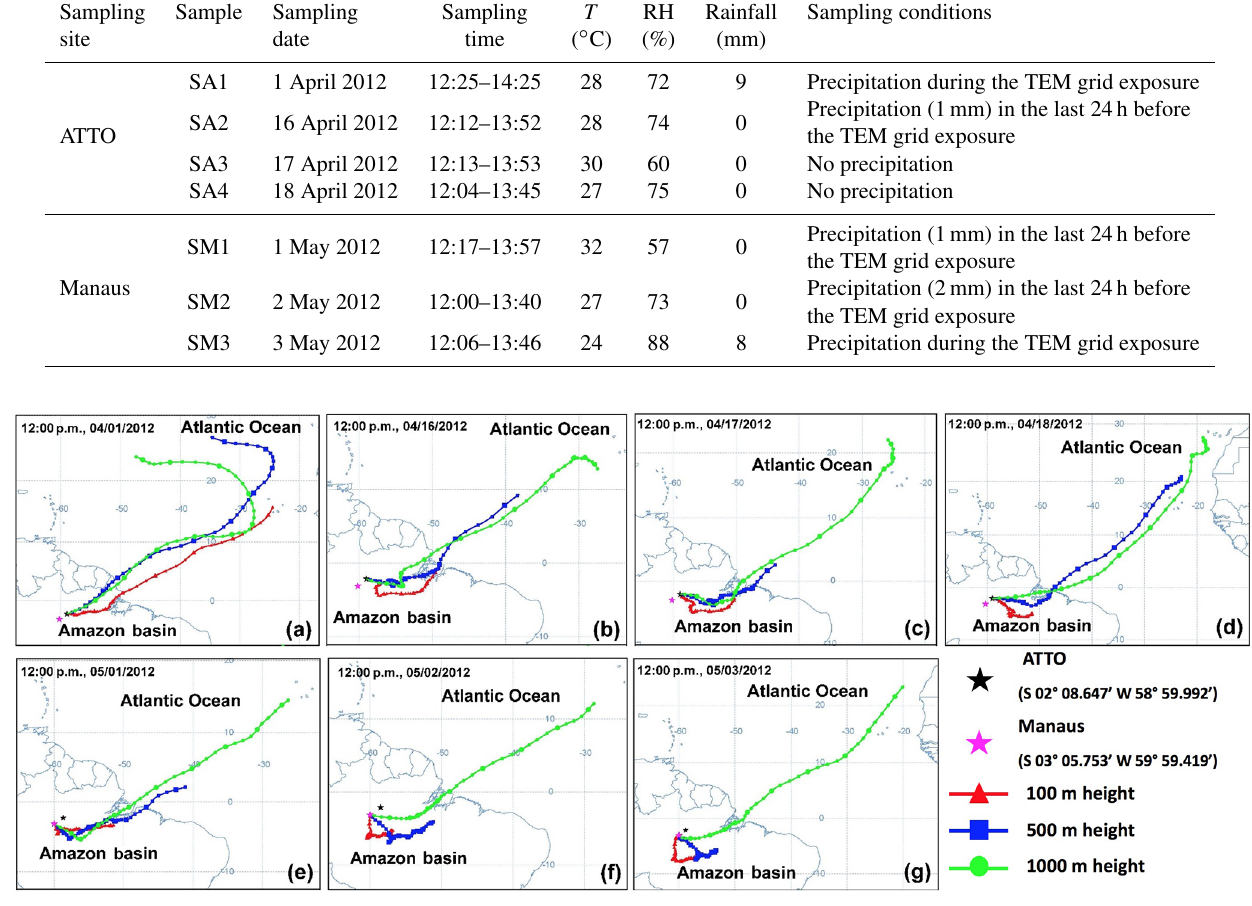
Figure 2. The 10-day (240h) backward air-mass trajectories at 100, 500, and 1000m receptor heights (a–d) for the SA1–SA4 samples collected on 1 and 16–18 April 2012 at the ATTO site and (e–g) for the SM1–SM3 samples collected on 1–3 May 2012 at the Manaus site. The Hybrid Single-Particle Lagrangian Integrated Trajectory (HYSPLIT) model available at the NOAA Air Resources Laboratory’s web server (http://www.arl.noaa.gov/ready/hysplit4.html, last access: 30 January 2019) was